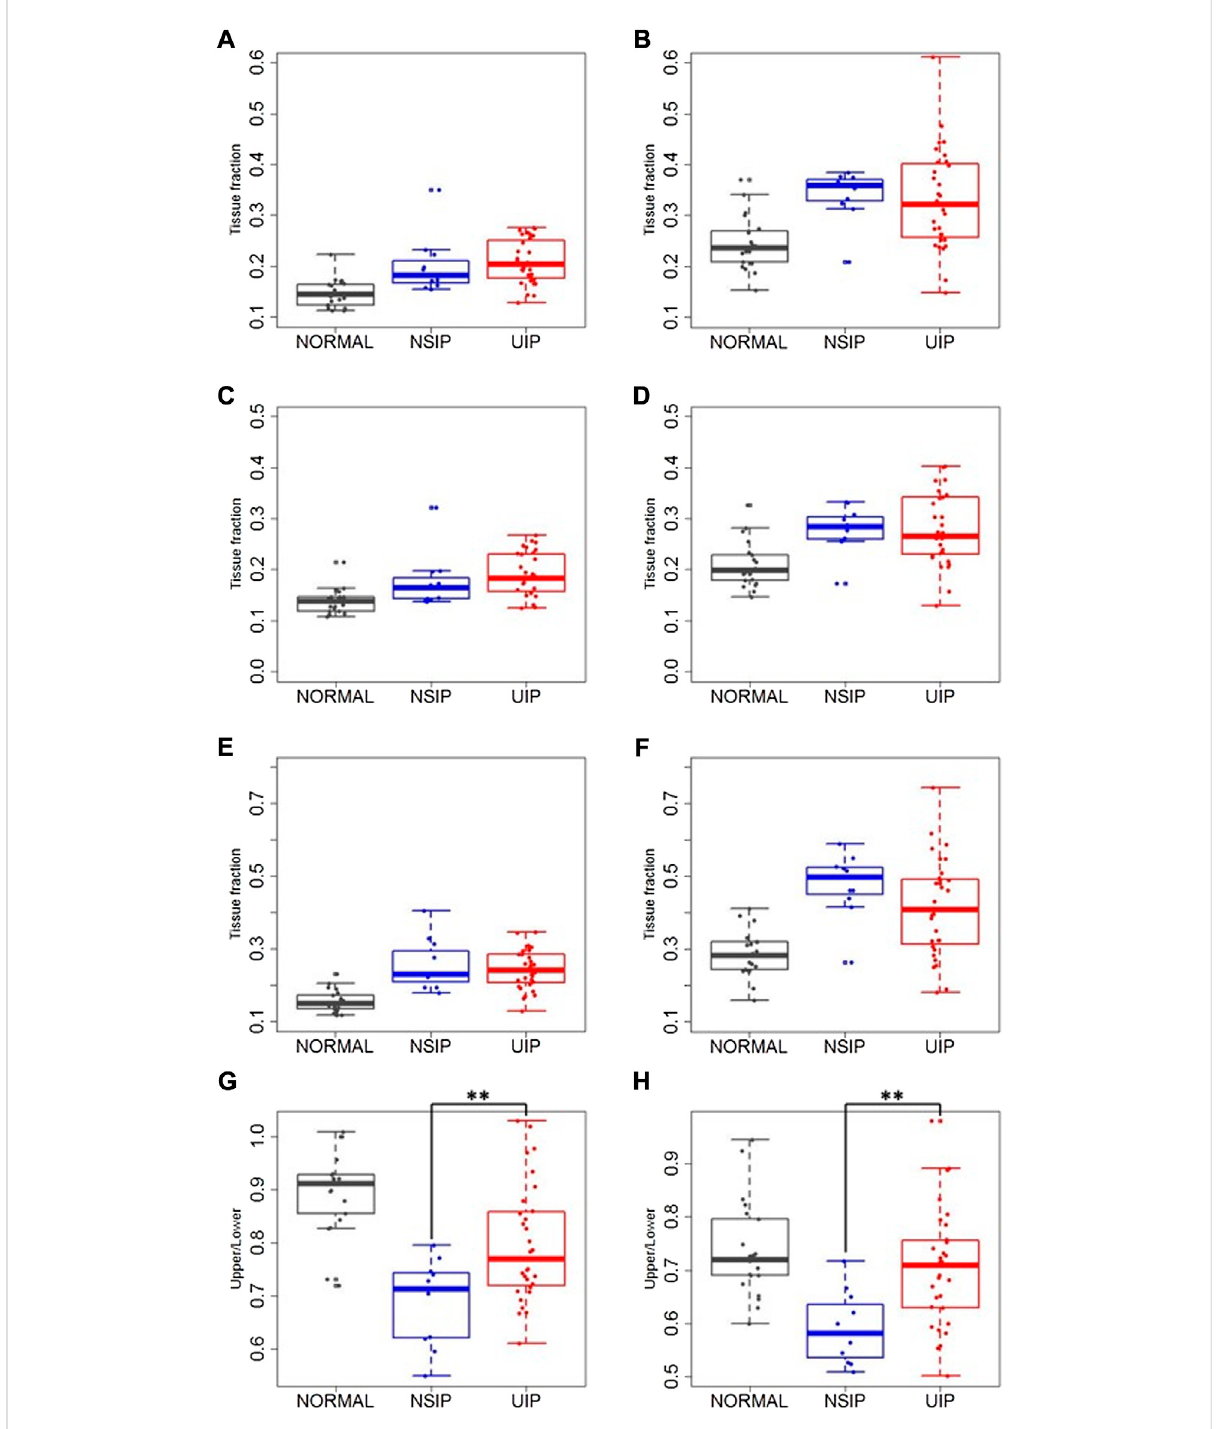
FIGURE 4 Local TFs on (A,C,E,G) inspiration and on (B,D,F,H) expiration in the whole lung (A,B) , upper and middle lobes (C,D) , lower lobes (E,F) , and upper – lower ratio (G,H) in normal, NSIP, and UIP subjects. ** denotes p <